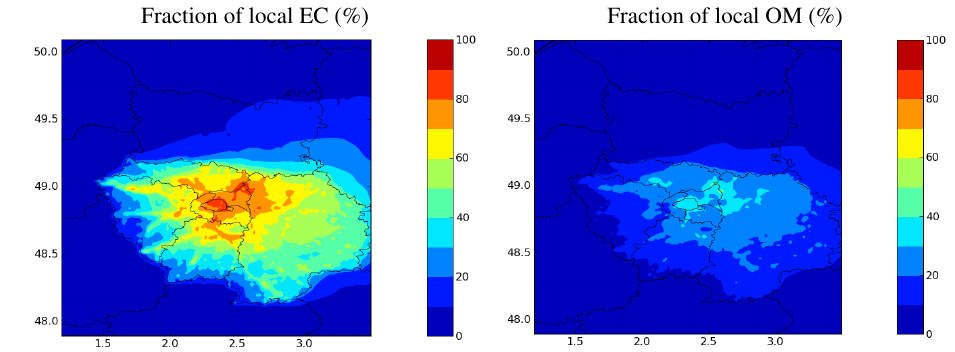
Fig. 12. Fraction of local aerosol in % (bottom) for EC (left) and OM (right) for July 2009.